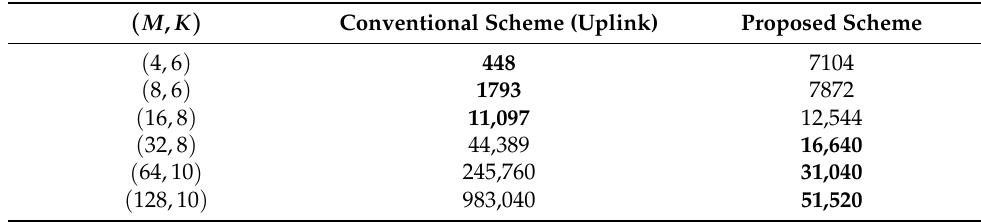
Table 1. Computational complexities for the various ( M , K ) pairs in the uplink. ( M , K ) Conventional Scheme